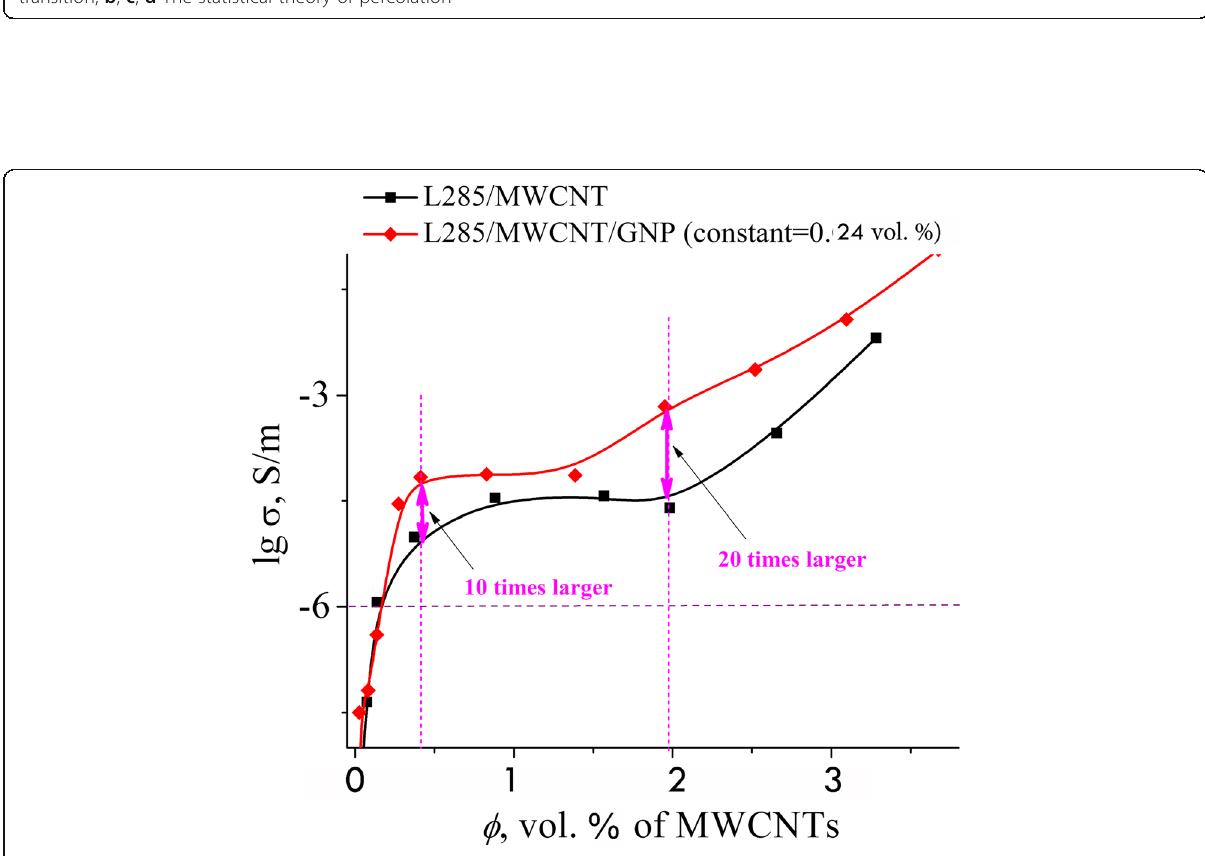
Fig. 3 a – d Scaling dependence (lg σ as a function of lg ( ϕ − ϕ cr )) for determining the parameters of Eq. (1). a The quasi-dynamic percolation transition, b , c , d The statistical theory of percolation